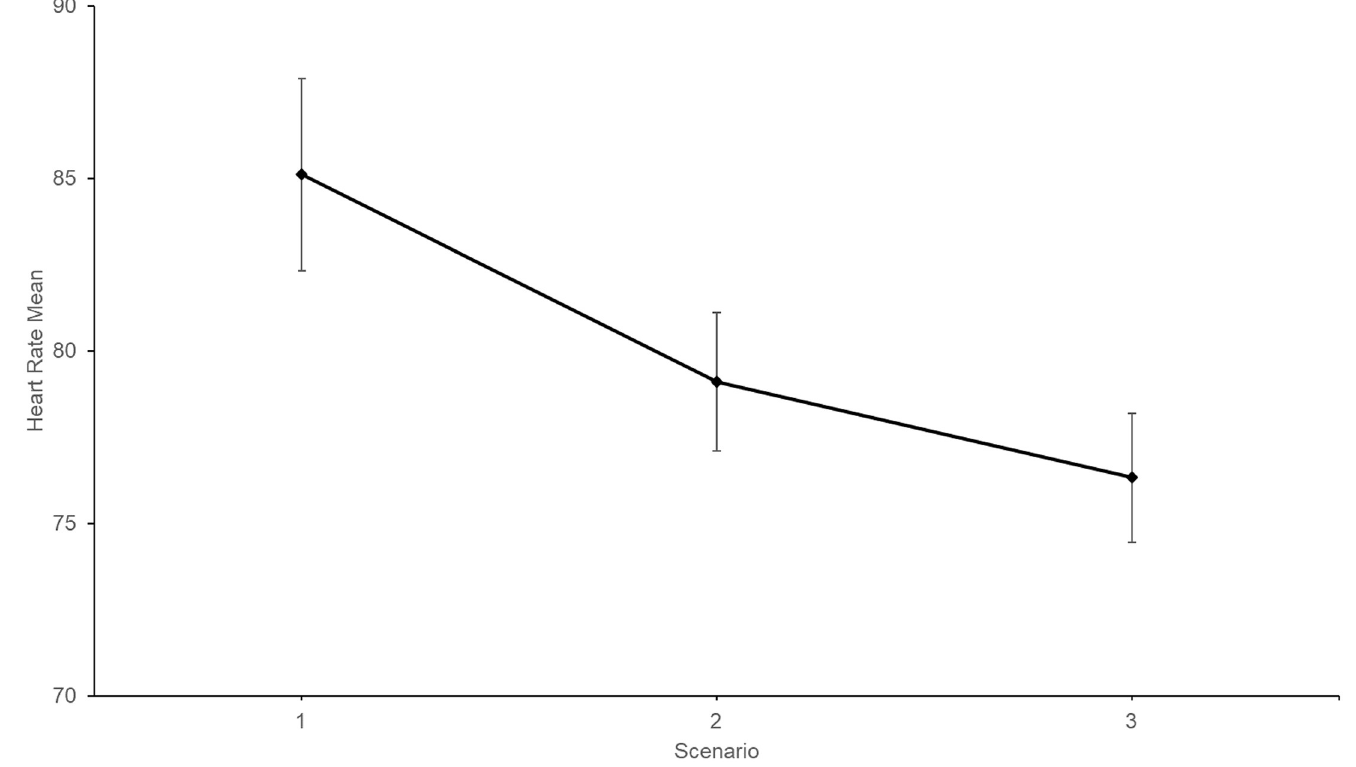
Fig 8. Pre-speech heart rate Time 1 mean scores for each scenario. Time 1 = 00:00 minutes. Error bars represent standard errors. ( N = 19).